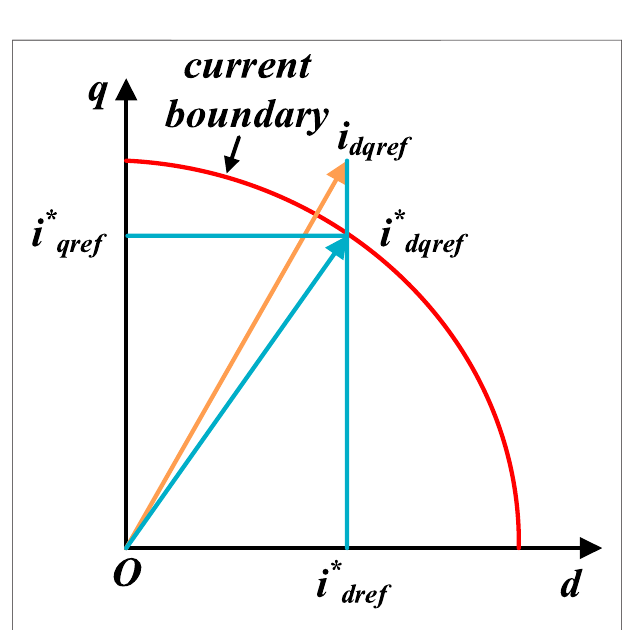
FIGURE 12 | The principle of d-axis priority current